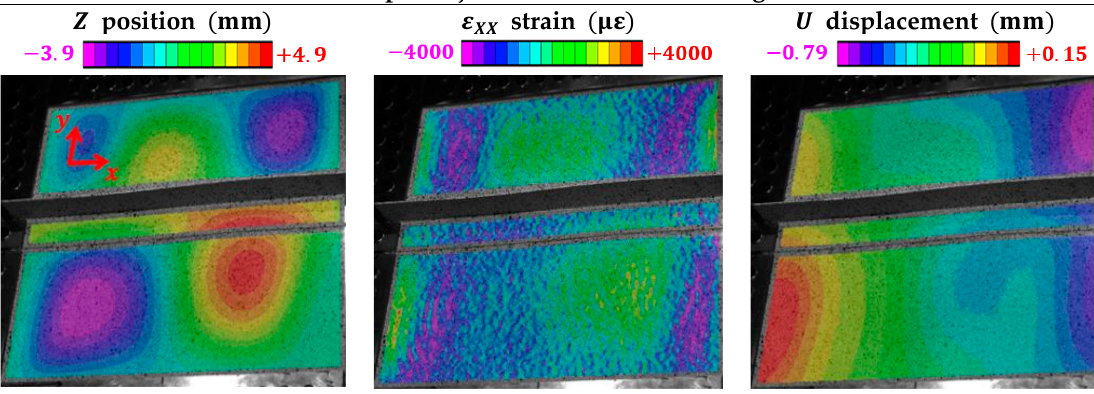
Figure 22. Loading state of Sample2 just before first debonding, obtained by stereo-correlation on the 400 mm × 400 mm useful